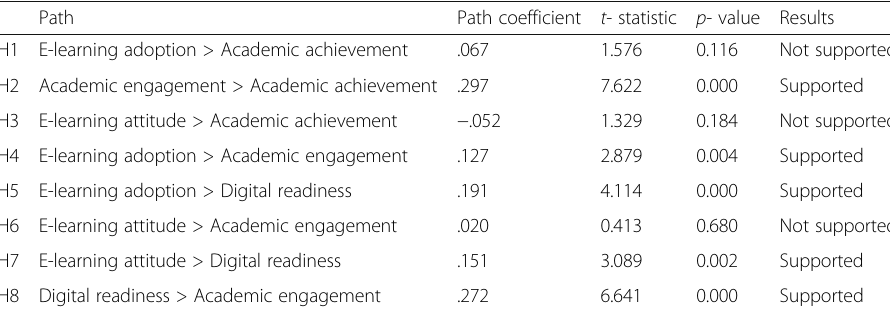
Table 5 Hypotheses, path coefficients, and results Path